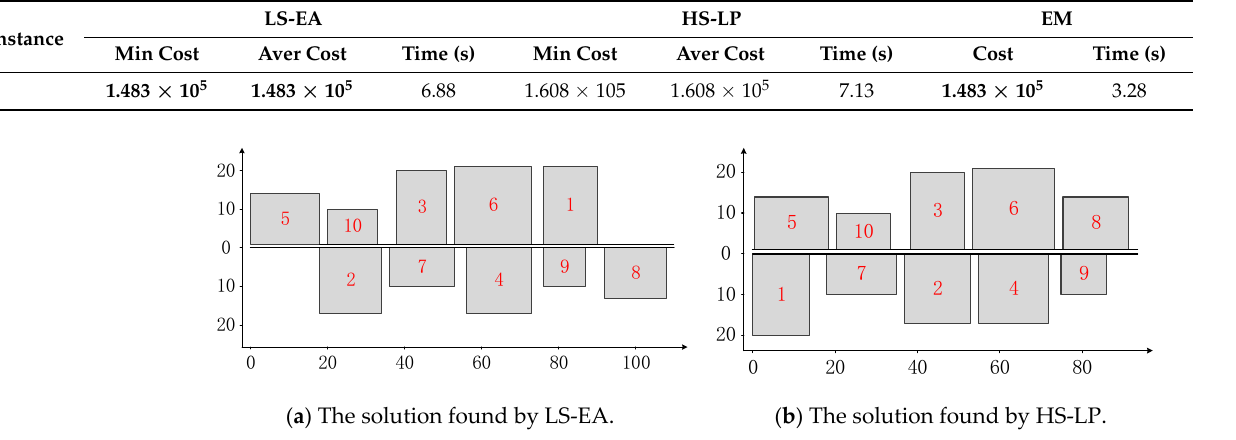
Figure 7. The best solution found by LS-EA with larger maxO and HS-LP with larger runtime for P10.